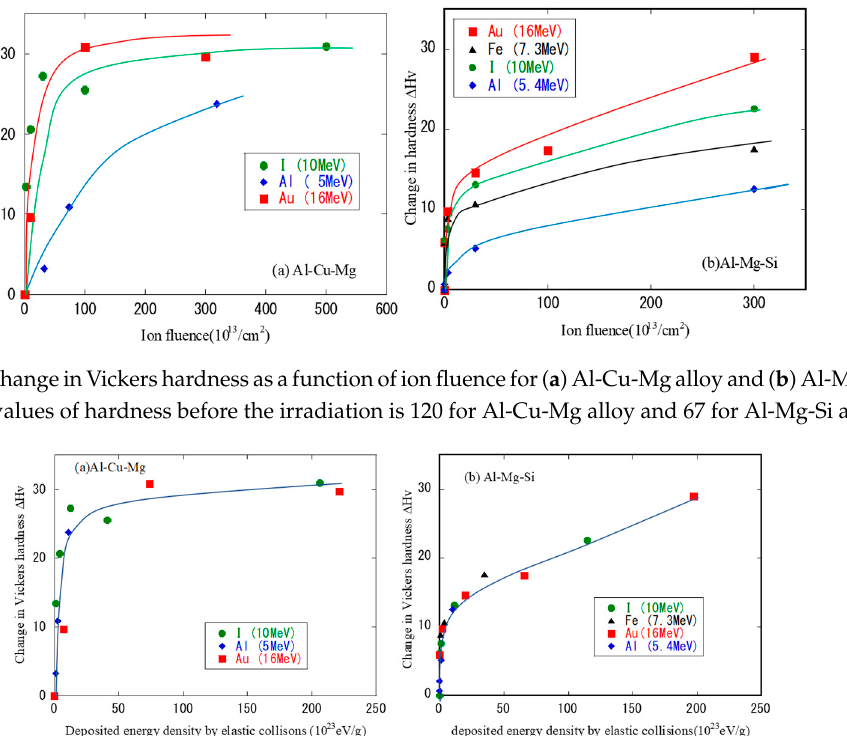
Figure 8. Results of nanoindentation for ( a ) Al-Cu-Mg alloy and ( b ) Al-Mg-Si alloy irradiated with 10 MeV I ions.